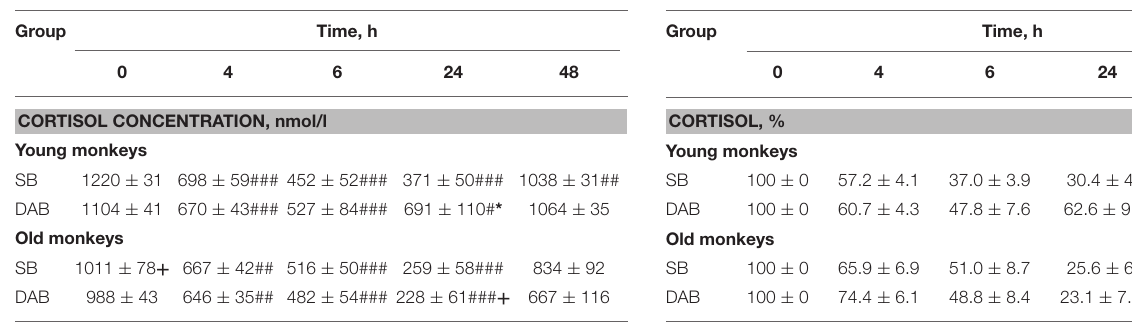
TABLE 2 | Dynamics of CORT concentration in peripheral blood plasma of young and old female rhesus monkeys with SB and DAB in response to administration of DEX (mean ± S.E.M.).